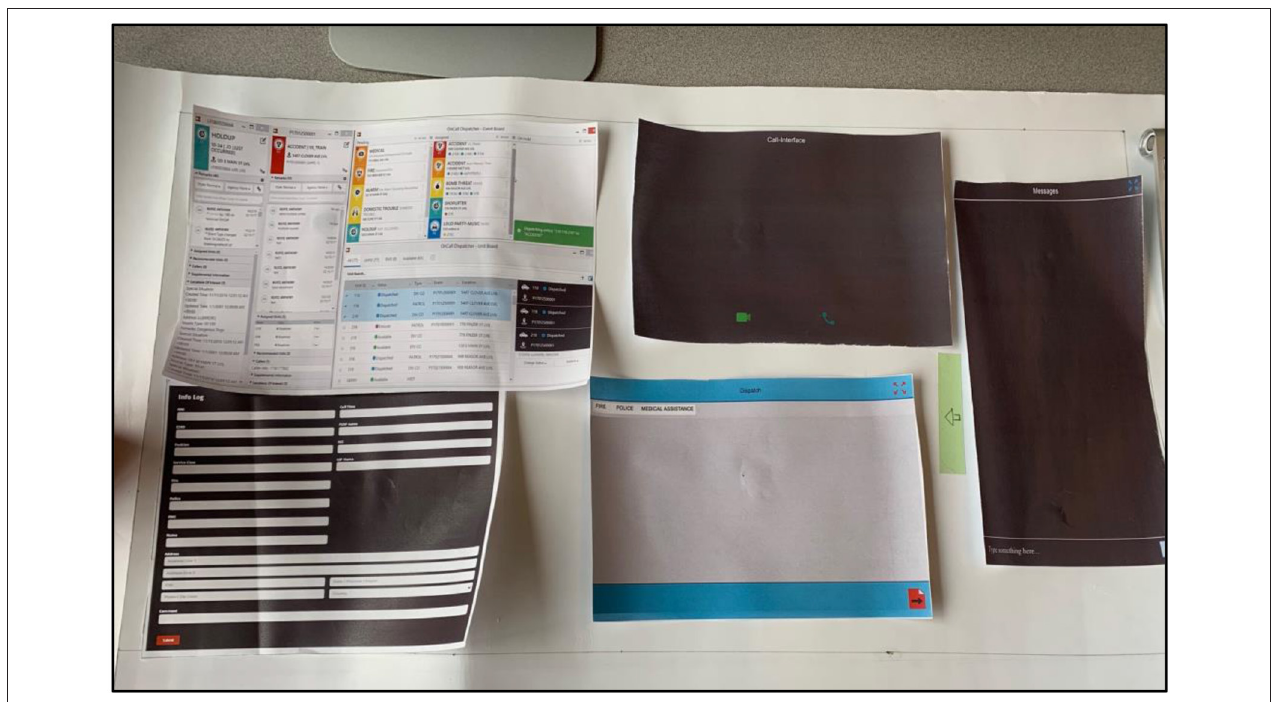
FIGURE 1 | Initial paper prototype of the UI